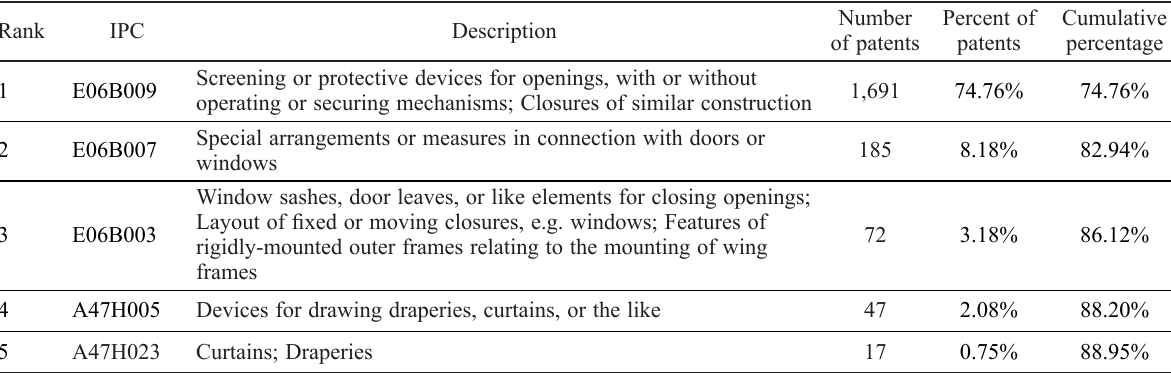
Table 3. Top 5 technology fields for the area of shading device